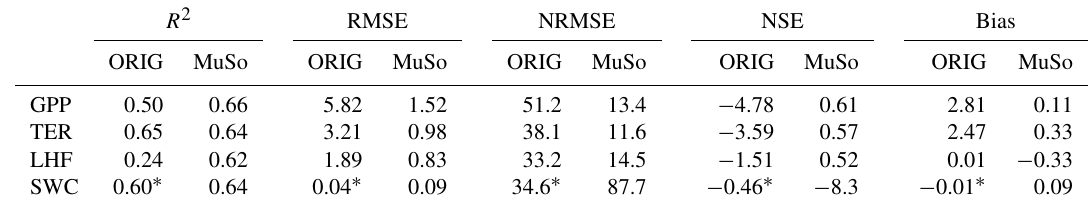
Table 4. Quantitative model evaluation regarding maize simulation at the Mead1 site using different error metrics. ORIG means the original Biome-BGC, while MuSo refers to the BBGCMuSo. See text for the definitions of the error metrics. R 2 RMSE NRMSE NSE Bias ORIG MuSo ORIG MuSo ORIG MuSo ORIG MuSo ORIG MuSo GPP 0.61 0.87 5.83 3.44 19.0 11.1 0.58 0.86 − 0.41 − 0.91 TER 0.59 0.86 − 0.83 SWC 0.12* 0.01 0.13* 0.09 41.2* 30.1 − 4.53* − 1.94 0.12* LAI 0.26 0.59 − 0.01 abgC 0.36 0.82 296.5 159.6 27.4 14.8 0.17 0.76 − 129.1 7.9 ∗ SWC simulated by the original Biome-BGC represents constant value within the entire root